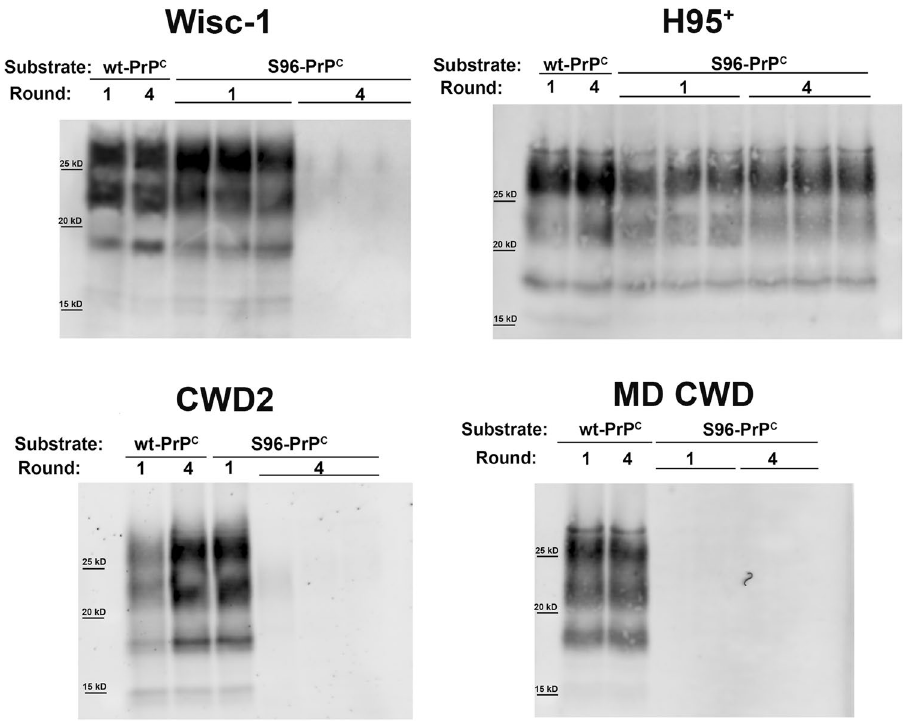
Figure 2. Serial PMCA amplification of Wisc-1, H95 + , CWD2 and MD CWD prions in wt and S96 PrP C substrates. 10 −3 dilutions of the CWD brain homogenates from infected cervids were used to seed wt-PrP C substrate (tg33 mouse brain homogenate) or S96-PrP C brain substrate (tg60 mouse brain homogenate) and subjected to 4 serial rounds of PMCA. Amplification products were digested with PK (50 µg/ml) and analyzed by western blot. Although all CWD strains were serially propagated in the wt-PrP C substrate, only the H95 + strain maintained its amplification efficiency in the S96-PrP C brain substrate through the serial rounds of PMCA. Wisc-1 and CWD2 strains lost their ability to misfold the S96-PrP C after serial rounds of PMCA. MD CWD isolate was not able to propagate in this substrate. mAb Sha31